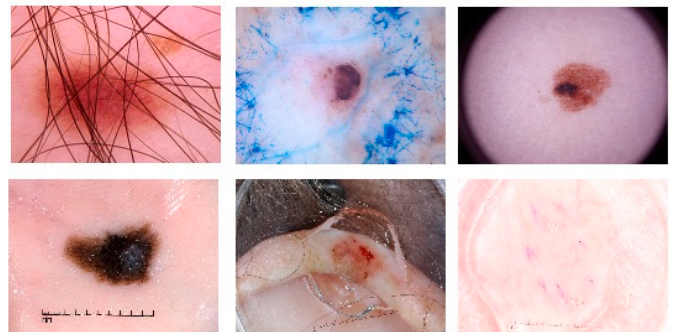
Figure 1. Various artifact examples in dermoscopic images. First row: hair artifact, ink marker artifact, dark corner artifact. Second row: ruler marker artifact, gel bubble artifact, and illumination artifact from left to right, respectively.